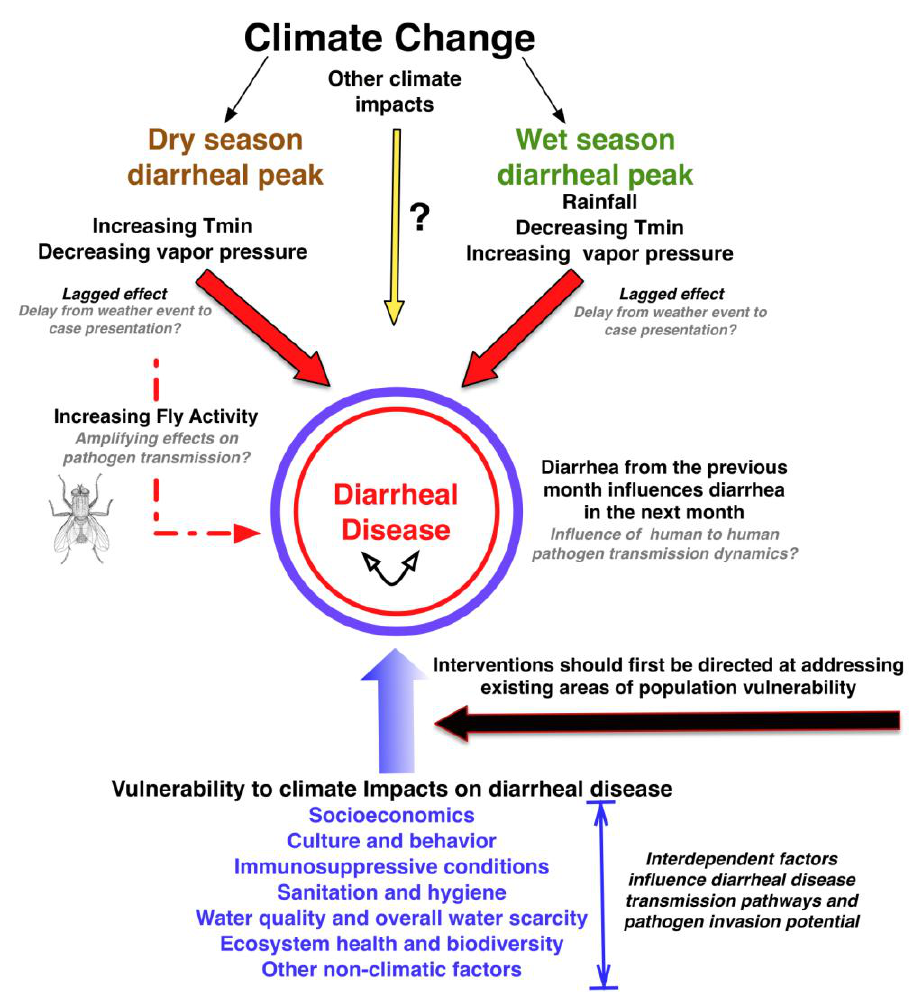
Figure 9. Schematic illustration of the potential interactions between climate